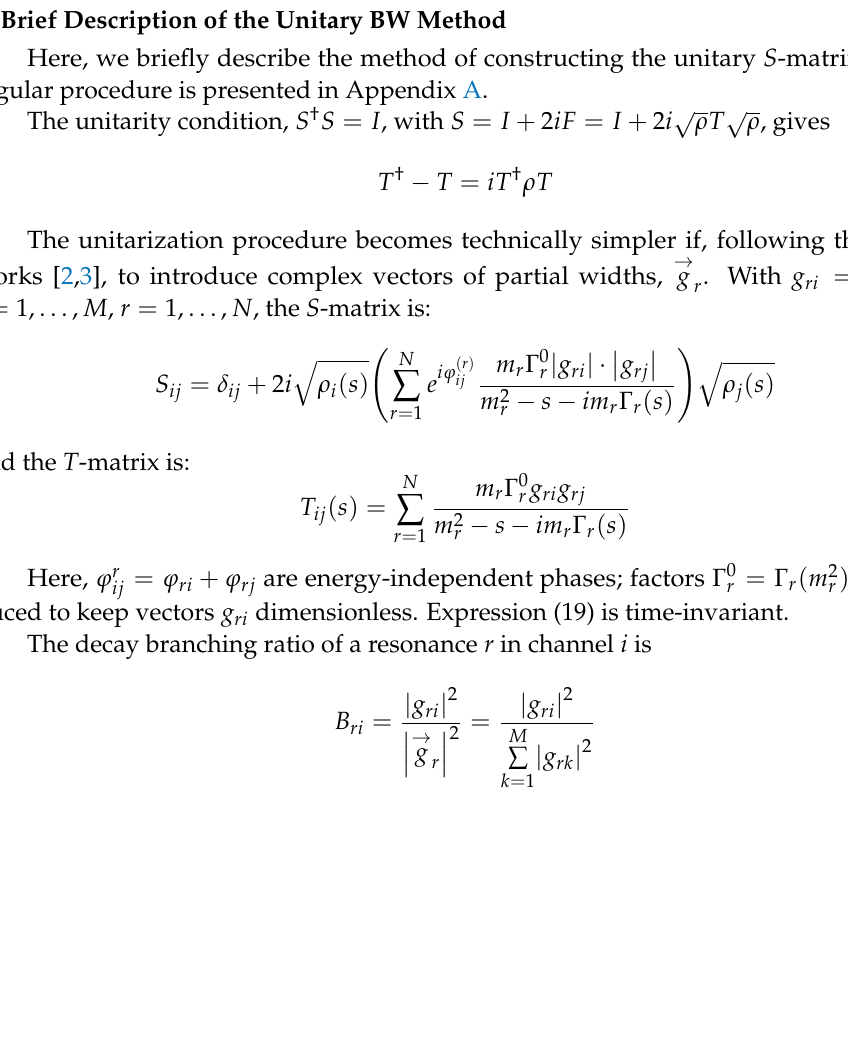
2 Figure 1. Plot of | S ( E ) | 2 for a sum of two BW functions. Green dashed-dotted line E 1 = 0.5, Γ 1 = 0.1, () S E Figure 1. Plot of for a sum of two BW functions. Green dashed-dotted line E 2 = 2.5, Γ 2 = 0.3; blue dashed line E 1 = 1.2, Γ 1 = 0.1, E 2 = 1.8, Γ 2 = 0.3; red solid line E 1 = 1.45, Γ = 0.1, E = 1.65, Γ = 0.3 (all in 2 2 1